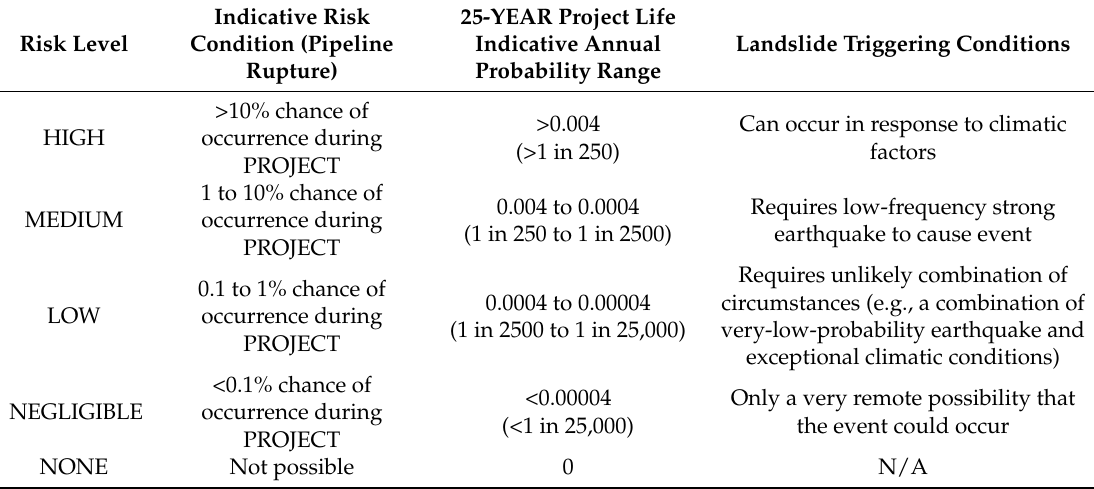
Table 2. Indicative annual probability ranges associated with different risk-level classes used in this work (ranges allow estimated landslide risks to be employed on a standard risk